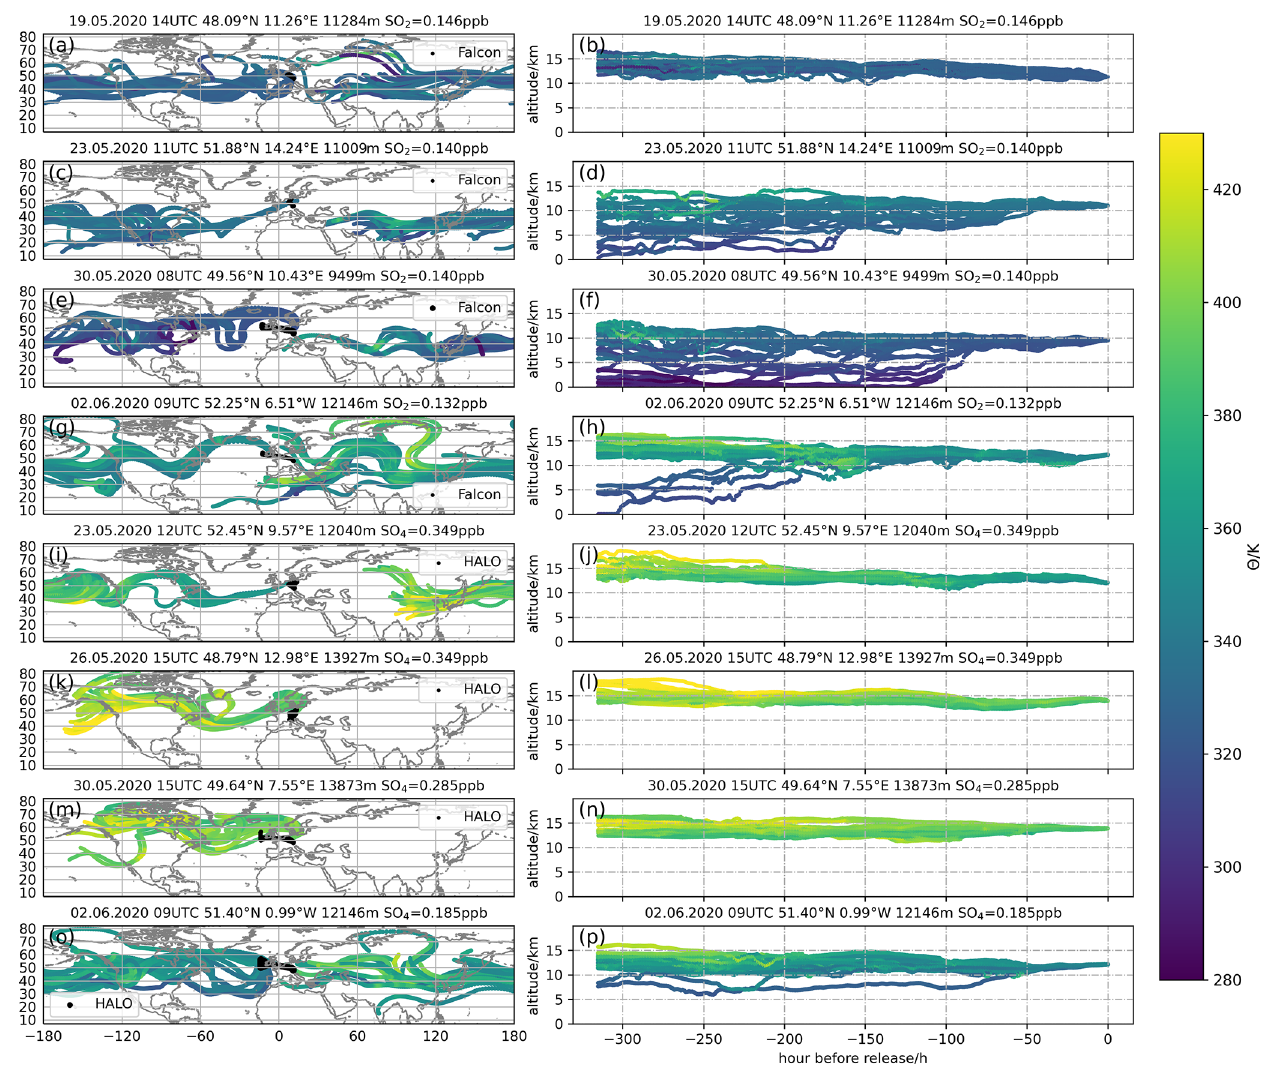
− ( i–p ; HALO ) mixing ratios. The Figure 5. HYSPLIT 360h back trajectories calculated for cases with elevated SO 2 ( a–h ; Falcon ) and SO 2 4 release points started in the vicinity of these events. Left column: the flight tracks are in black, and the potential temperature along the tra- jectories to indicate the transport altitude is color-coded. The right column represents the trajectories as hours before release vs. altitude, also with color-coded potential temperature. The cases of enhanced SO 2 were on 19 May 2020 (a, b) , 23 May 2020 (c, d) , 30 May 2020 (e, f) , and 2 June 2020 (g, h) . The cases of elevated SO 2 − were on 23 May 2020 (i, j) , 26 May 2020 (k, l) , 30 May 2020 (m, n) , and 2 June 2020 (o, p) 4